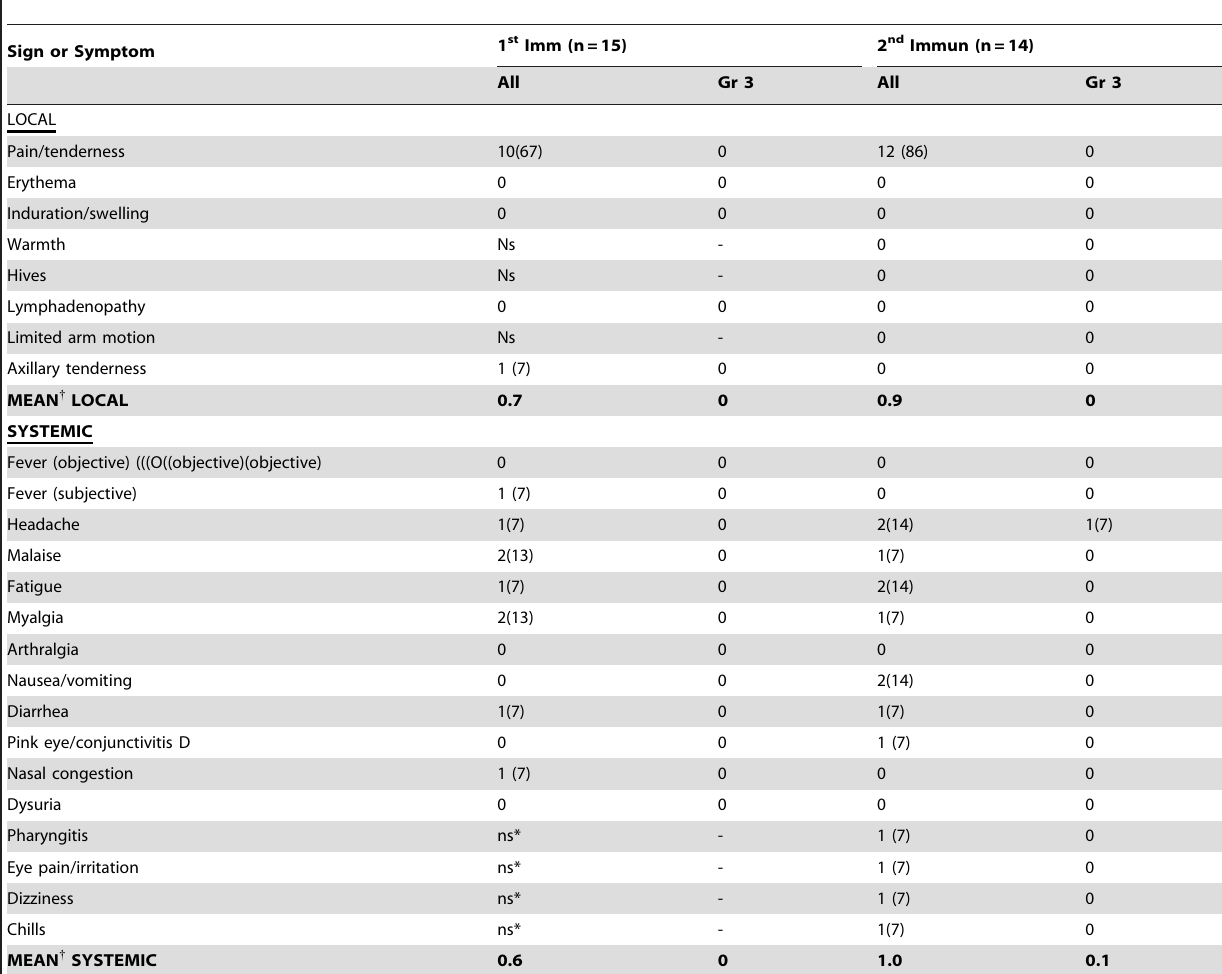
Table 4. Number (percent) of volunteers experiencing solicited local and systemic adverse (definitely, probably or possibly related to immunization).